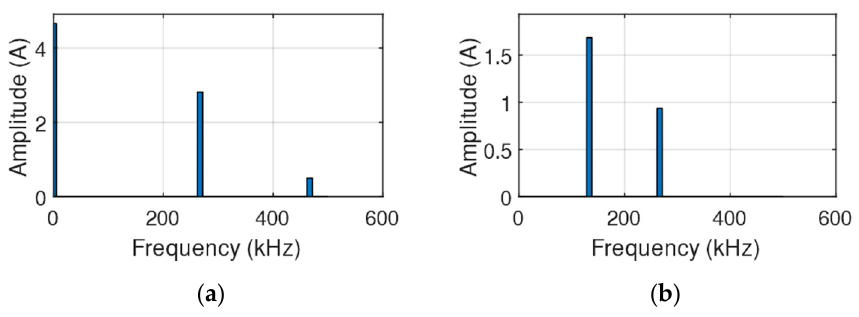
Figure 15. Results of spectral analysis for: ( a ) The input current and ( b ) the output current.